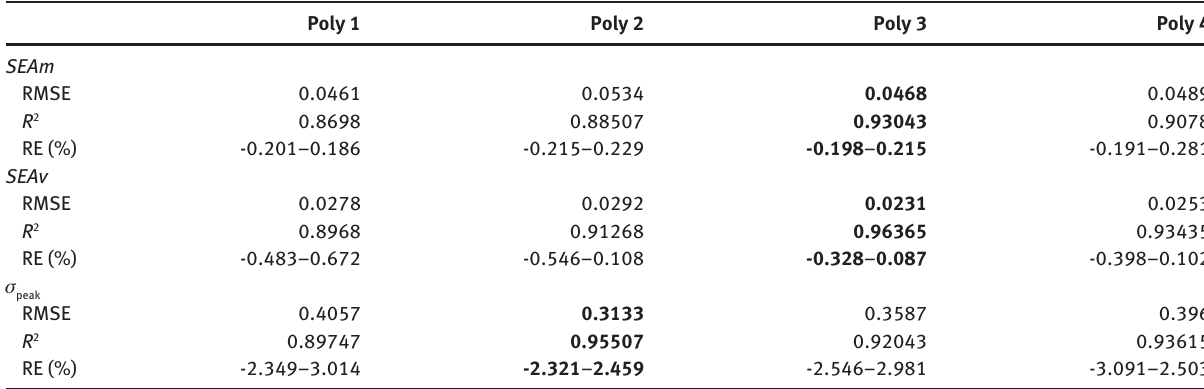
Table 7: Accuracy of different polynomial RSM models for